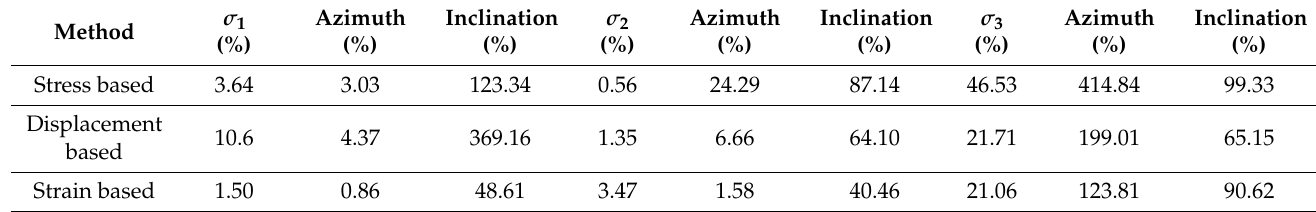
Table 4. The statistical relative errors between inversion results and measurement